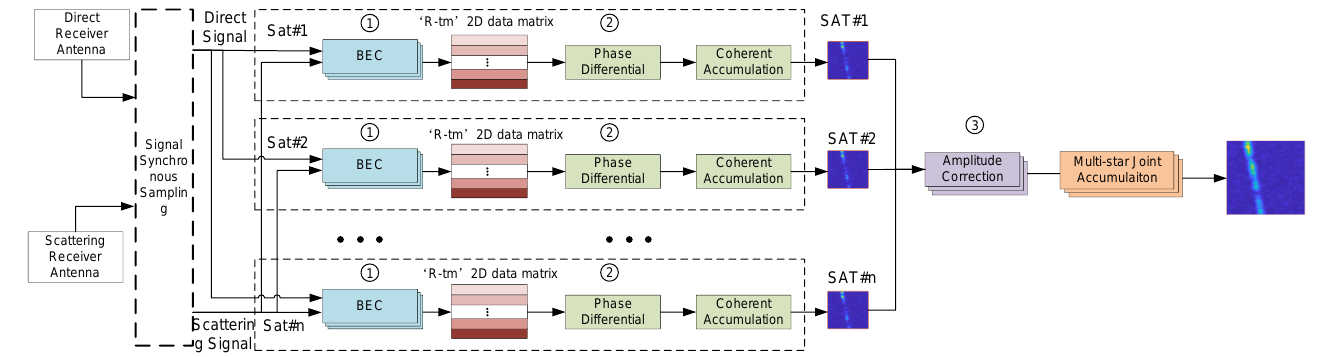
Figure 3. Signal Processing Flowchart.